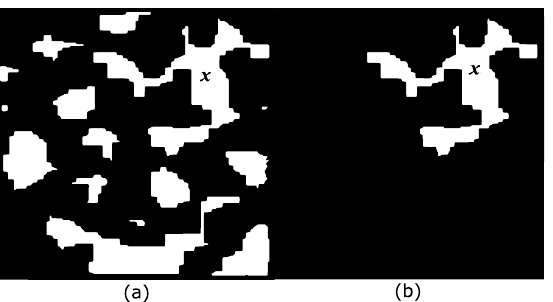
Figure 2. Punctual opening. ( a ) Original image X and the marker x ; ( b ) The punctual opening γ x ( X ) extracts the component where marker x is